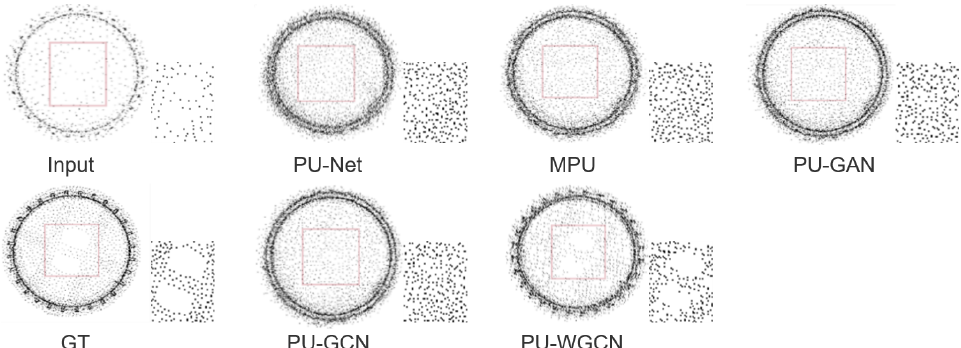
Figure 11. Upsampling visualization results of group a. We show the upsampled results when